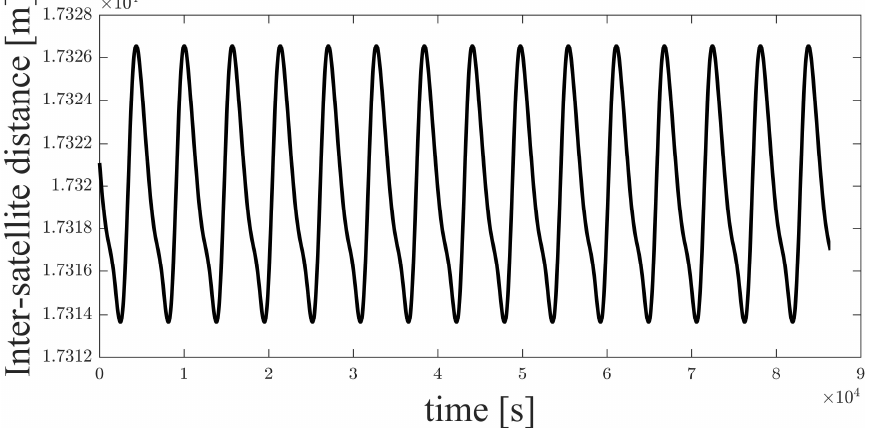
Figure 7. Time history of inter-satellite distance.